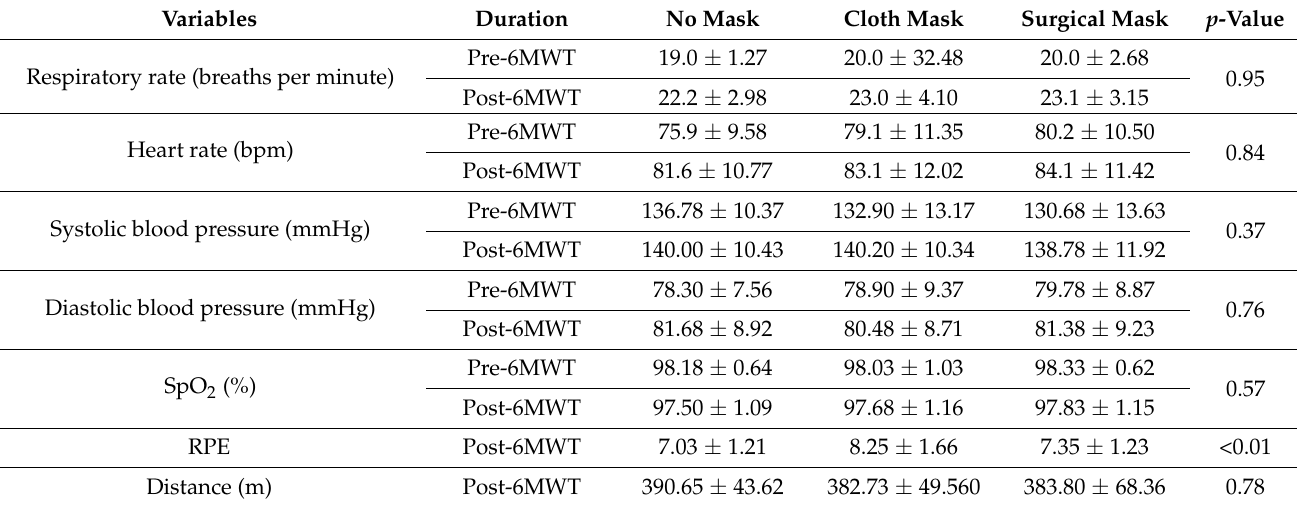
Table 3. Effects of face masks on cardiorespiratory parameters at 6MWT.